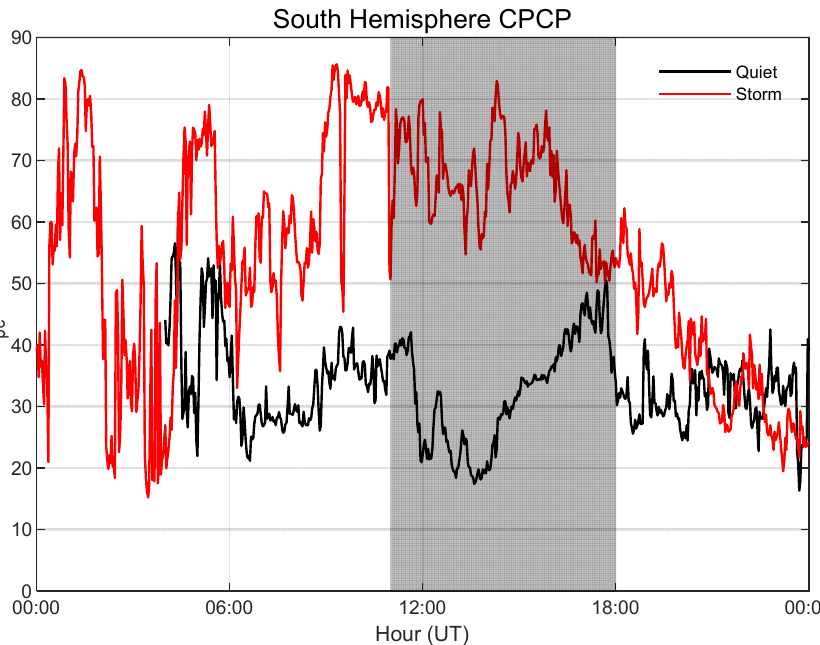
Figure 7. Cross-polar cap potential (CPCP) values at the South Pole as derived from SuperDARN. Φ PC on the quiet day and storm day are represented by black and red lines, respectively. The shaded area indicates the time period of the positive ionospheric storm.